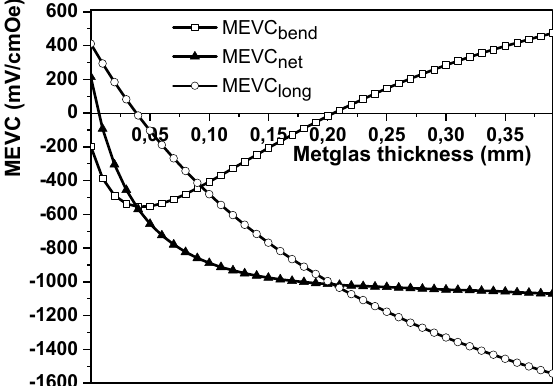
Figure 2. Estimated dependence of MEVC in a Ni-PZT-Metglas first-type three-layered structure on the Metglas layer thickness. The PZT layer thickness t p = 0.2 mm, the Ni thickness t m 1 = 0.2 mm.